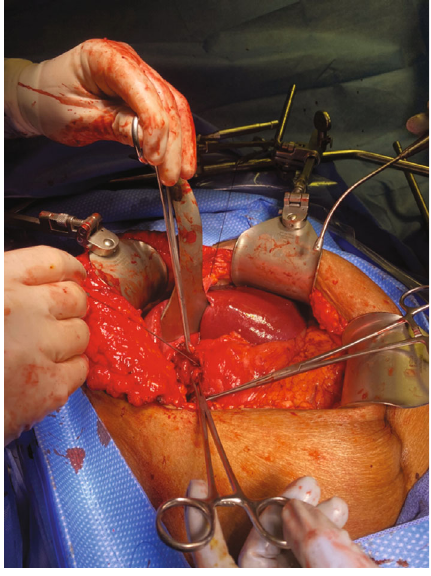
Figure 5: Intraop picture of the CBD after stone extraction. The CBD is marked by the